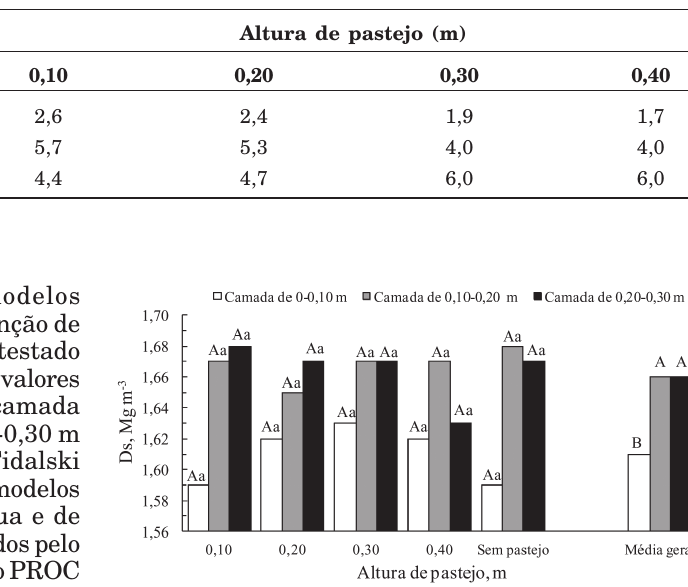
Figura 1. Densidade do solo (Ds) para os tratamentos de altura de pastejo (0,10; 0,20; 0,30; e 0,40 m e sem pastejo) e média dos cinco tratamentos nas camadas de 0-0,10; 0,10-0,20; e 0,20-0,30 m do Latossolo Vermelho distrófico típico, em